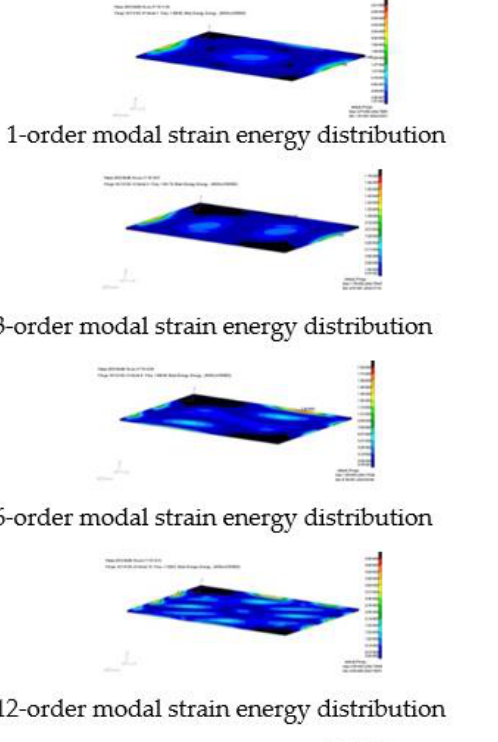
Figure 4. The typical strain energy of the composite plate.